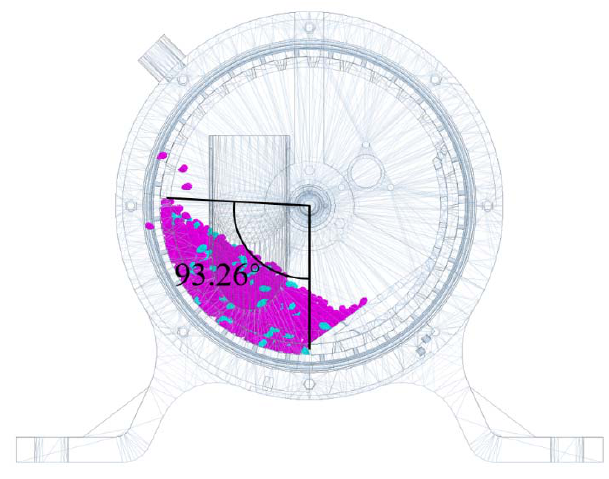
Figure 15. The simulation validation test process of seed ‐ metering device.